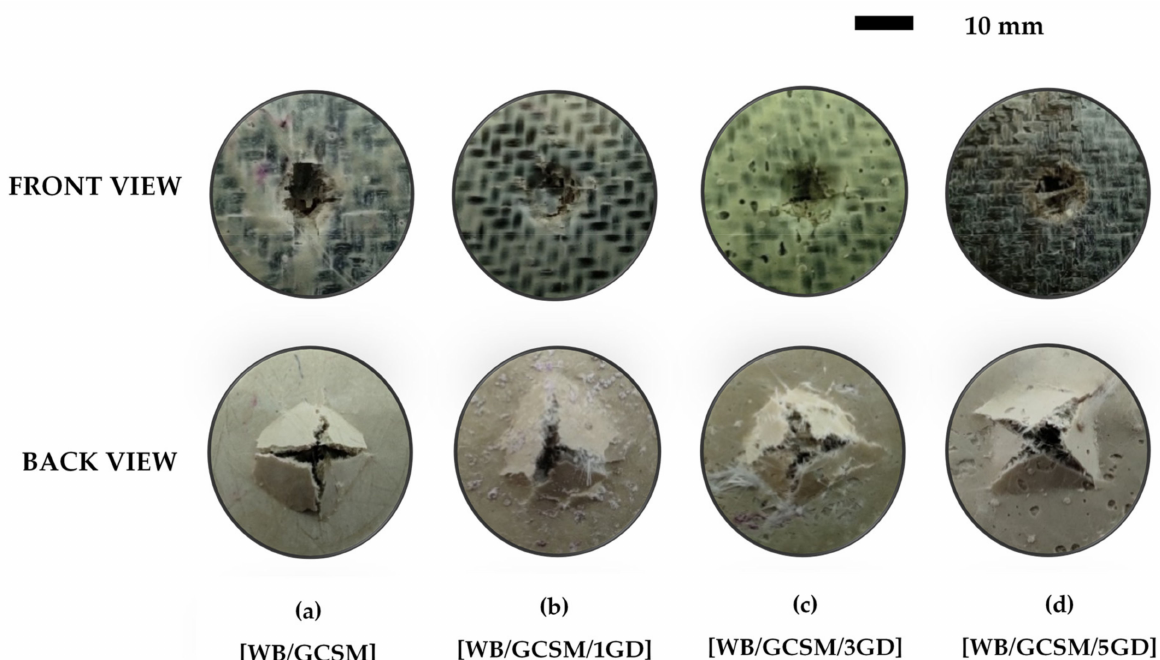
Figure 7. Damage fracture of [WB/GCSM], [WB/GCSM/1GD], [WB/GCSM/3GD] and [WB/GCSM/5GD] composites after being subjected to QSI